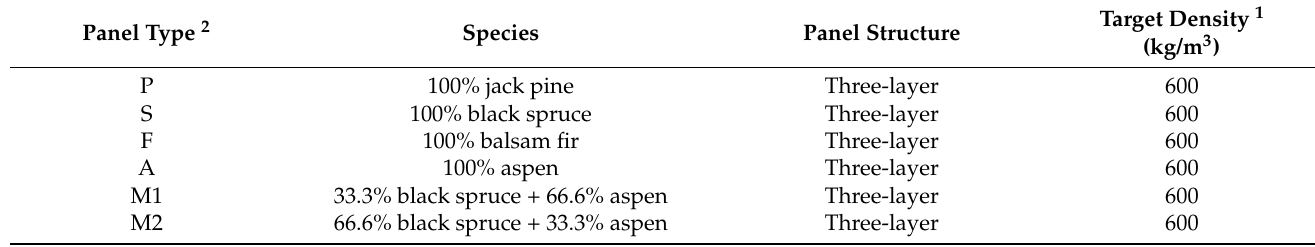
Table 1. Panel fabrication and structure.